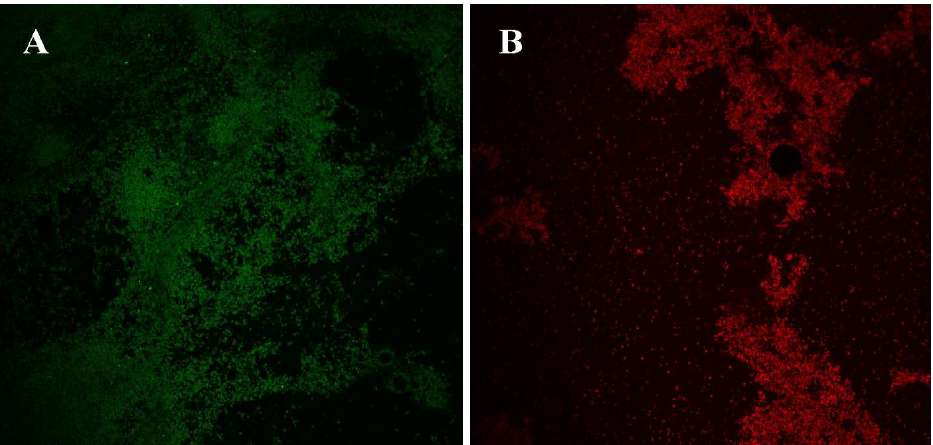
Figure 4. Confocal laser scanning micrographs ( × 60 magnification) of stained bacterial biofilms. Green: live cells; red: dead cells. ( A ) Untreated Acetobacter spp. ( B ) treated with CSA-131 (100 μg/mL).